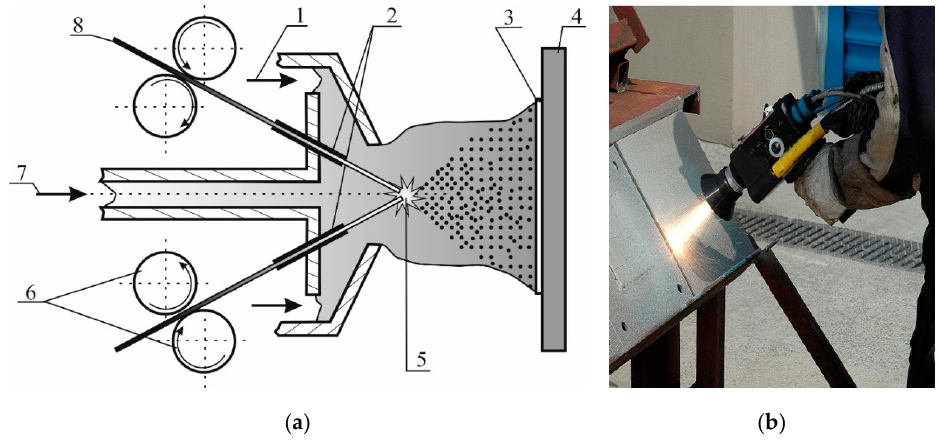
Figure 1. Spraying process: ( a ) scheme of wire arc spraying apparatus: 1—compressed air; 2—wire electric contact; 3—sprayed layer; 4—base metal; 5—electric arc; 6—wire feeder; 7—compressed air; 8—welding wire; ( b ) photo of manual arc spray trial run.